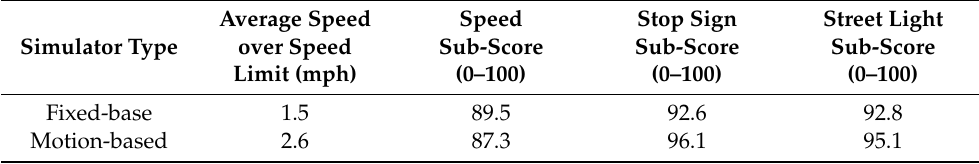
Table 3. Score Report Metrics by Simulator Type (Entire Cohort).